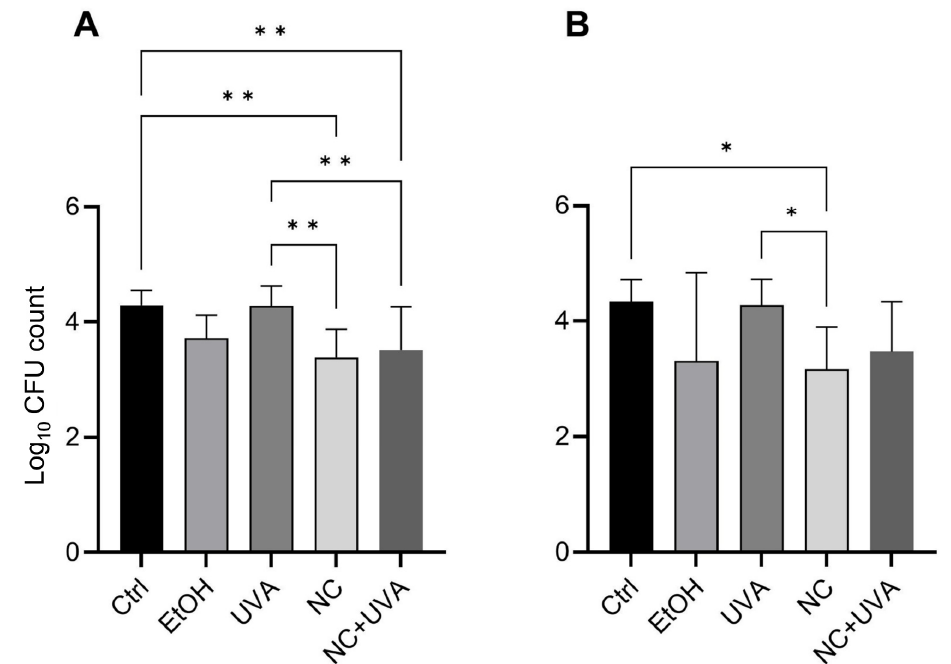
Figure 10. Log 10 values of ex vivo porcine skin colonization for untreated skin (Ctrl) after treatment with 80% EtOH with betaine monohydrate (EtOH), UVA irradiation (UVA), HES-NCs in 80% EtOH with 0.1% betaine monohydrate (NC) and HES-NCs in 80% EtOH with 0.1% betaine monohydrate + irradiation with UVA (NC + UVA) for bacteria cultivated under aerobic conditions ( A ) and bacteria cultivated under anaerobic conditions ( B ). Significances between the treatments are indicated by asterisks with * = p < 0.05, ** = p < 0.01 as determined by Tukey post hoc tests after one-way ANOVA. Mean values ± standard deviations are presented for n = 10 porcine ear skin samples.